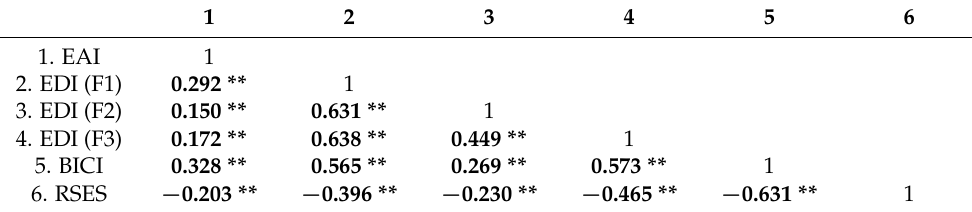
Table 2. Pearson’s correlation, means, and standard deviations of the study